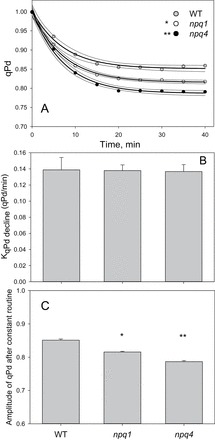
(A) Onset of qPd formation over a constant 1500 μmol m–2 s–1 light routine, illustrated in Fig. 1. Grey circles indicate WT, white npq1, and black npq4 Arabidopsis leaves. The darker lines indicate regression fit curves [exponential decay, single, three parameter; f=y
0+a×exp(–bx)], and the lighter lines represent 95% confidence intervals, all plotted using SigmaPlot12 (Systat Software, Inc.). (B) Rate constant for qPd formation, obtained via the equation generated from the regression fit curve. Error bars show the SD. (C) Amplitude of qPd formation derived from the equation for the fitting of the regression curve (from A). Error bars illustrate the SD. A single asterisk is used to signify this significant difference between mutants and WT plants, with a double asterisk representing a significant difference between npq1 and npq4 plants (P<0.05).